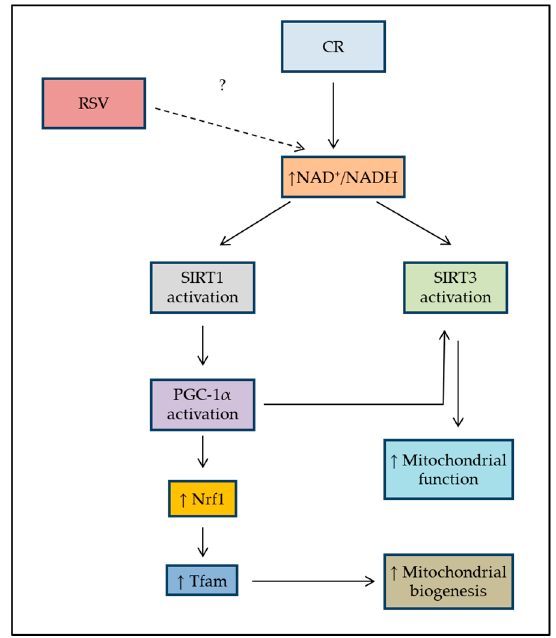
Figure 1. Schematic diagram showing the investigated pathways in the present study using RSV in patients and controls, adopted accordingly [21]. Caloric restriction (CR) activates the SIRT1 levels or NAD + levels leading to the activation of PGC-1 α in the nucleus, which then activates the transcription of genes that are necessary for mitochondrial function and biogenesis. CR also leads to activation of AMPK and, therefore, the activation of PGC-1 α in skeletal muscle. RSV: Resveratrol; NAD: